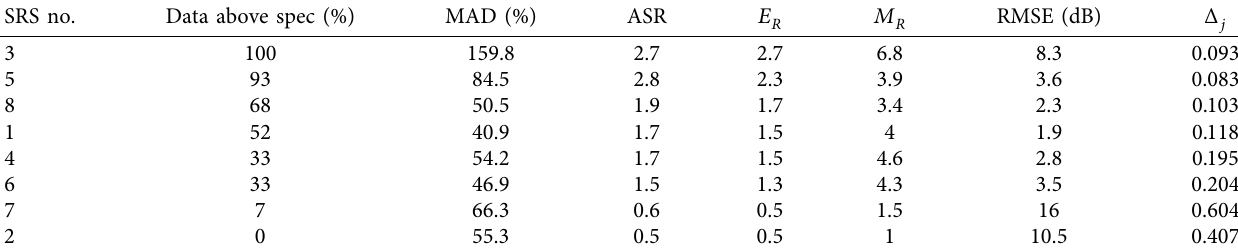
Table 3: Comparison of different methods for SRS database retrieval (database size � 10).